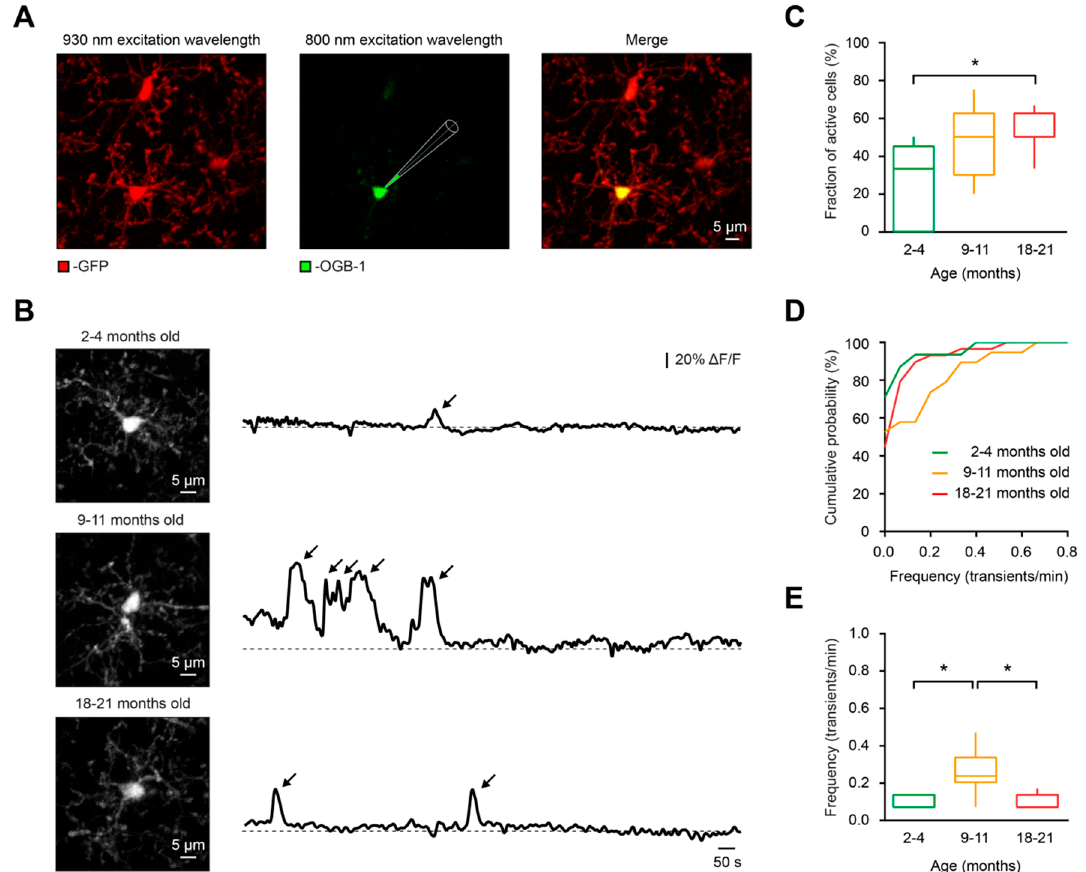
Figure 1. In vivo measurements of spontaneous Ca 2+ signals in microglia. ( A ) In vivo labeling of microglial cells with the Ca 2+ indicator OGB-1 by means of single-cell electroporation in a Cx 3 CR1 GFP/+ mouse. Green fluorescent protein (GFP) was excited at an excitation wavelength of 930 nm (left), whereas OGB-1 was excited at 800 nm (middle). Merged image is shown on the right. ( B ) From top to bottom: Maximum intensity projection (MIP) images of representative microglial cells from 4, 11- and 21-month-old mice (left) and the respective spontaneous somatic Ca 2+ transients recorded during a 15-min-long period (right). The arrows point to spontaneous Ca 2+ transients in respective cells. Here and below, Δ F/F means relative change in fluorescence. ( C ) Box-and-whisker plot illustrating fractions (per mouse) of spontaneously active cells in 2–4- (green), 9–11- (orange), and 18–21- (red) month-old mice. The fraction of spontaneously active cells was significantly higher in old mice